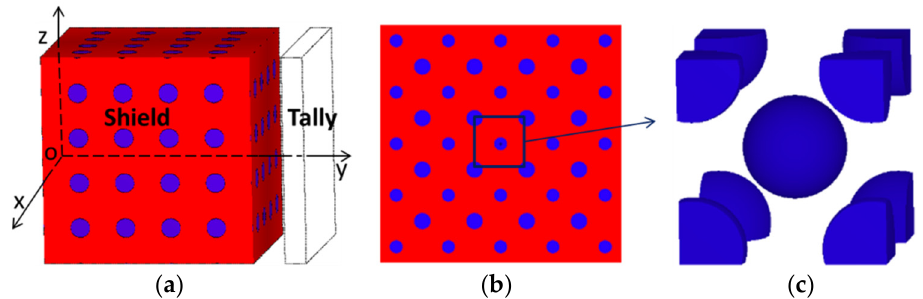
Figure 1. BCC Model for MCNP simulation; ( a ) the whole calculation model, ( b ) X-Z cross section of the model, ( c ) the BCC Model Unit).